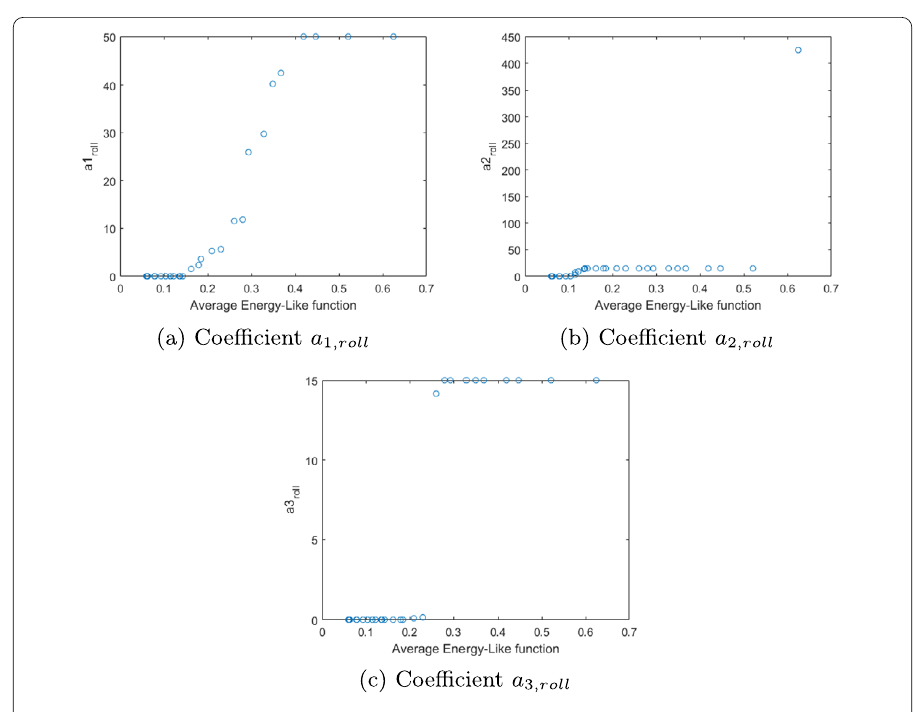
Figure 20 The identified coefficients for the roll